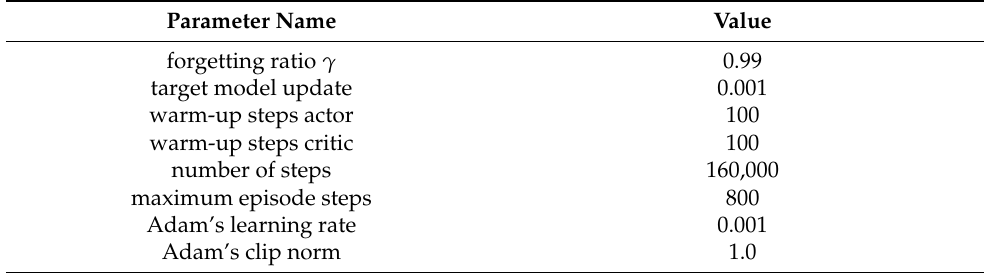
Figure 4. The example of noise added to action to provide exploration: Gaussian White Noise Process ( a ) and Ornstein Uhlenbeck Process ( b ). Table 3. The hyperparameters of the learning